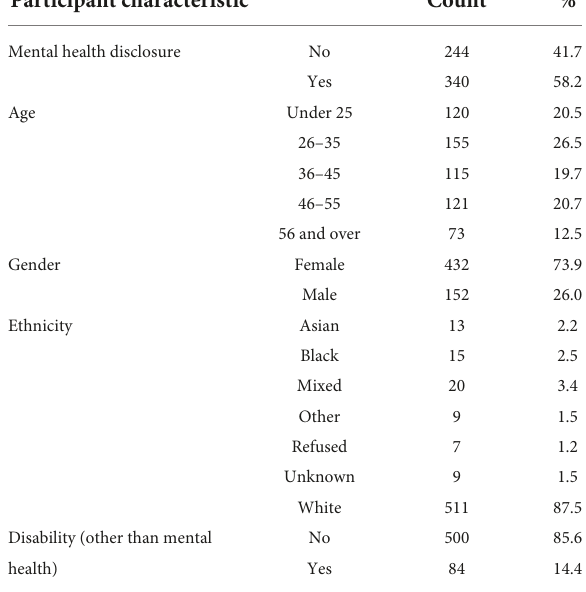
TABLE 3 Open University Mental Health project student survey respondents’ characteristics. Participant characteristic